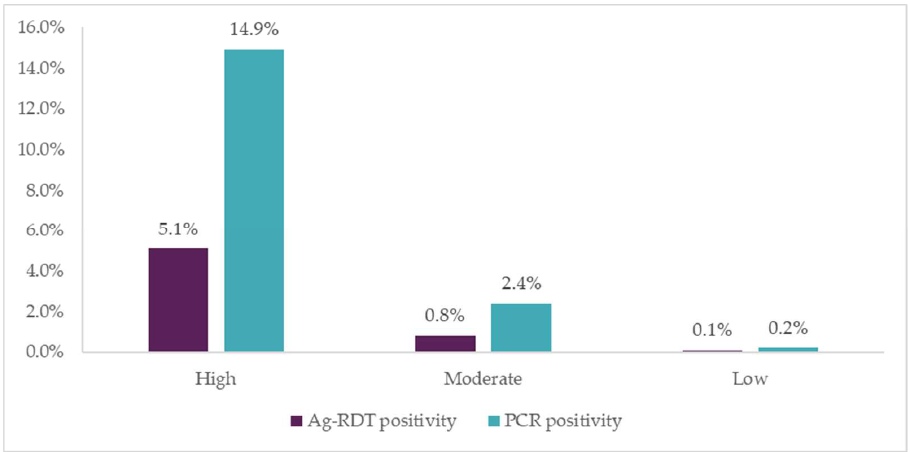
Figure 4. SARS-CoV-2 positivity rate for Ag-RDT and PCR tests by risk